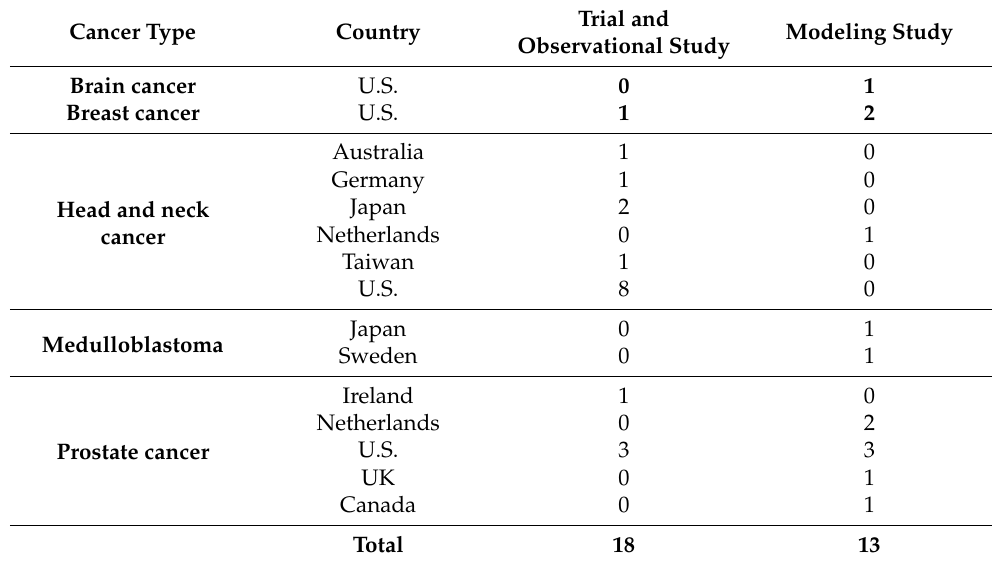
Table 1. General study characteristics of included literature. Cancer Type